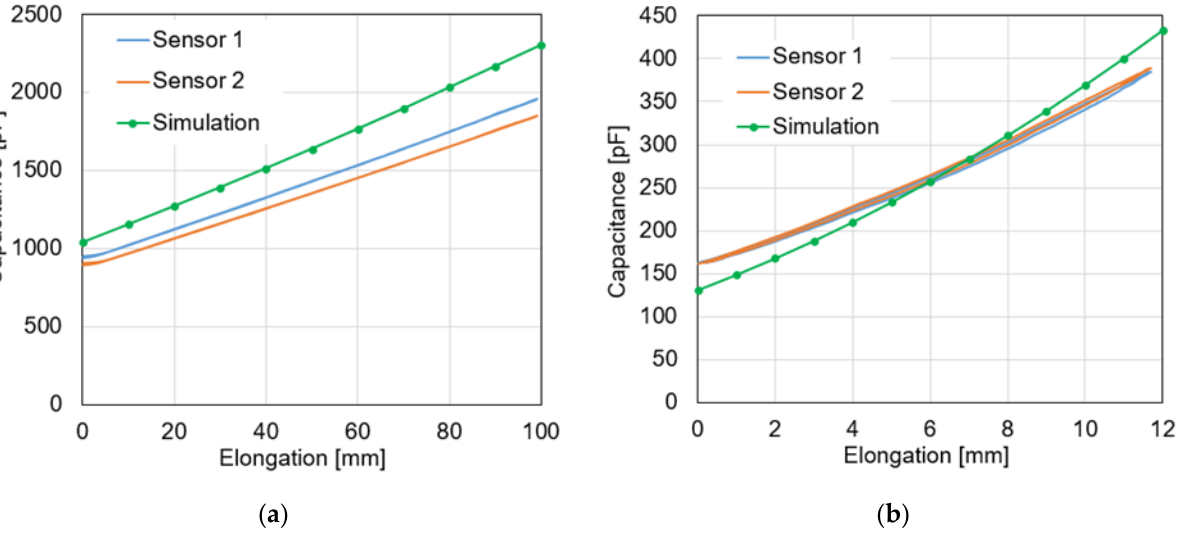
Figure 17. Dependence of the capacitance on the elongation from FEM simulation and from meas- urements on two sensors: conventional strain sensor as reference ( a ) and advanced strain sensor ( b ) [101].